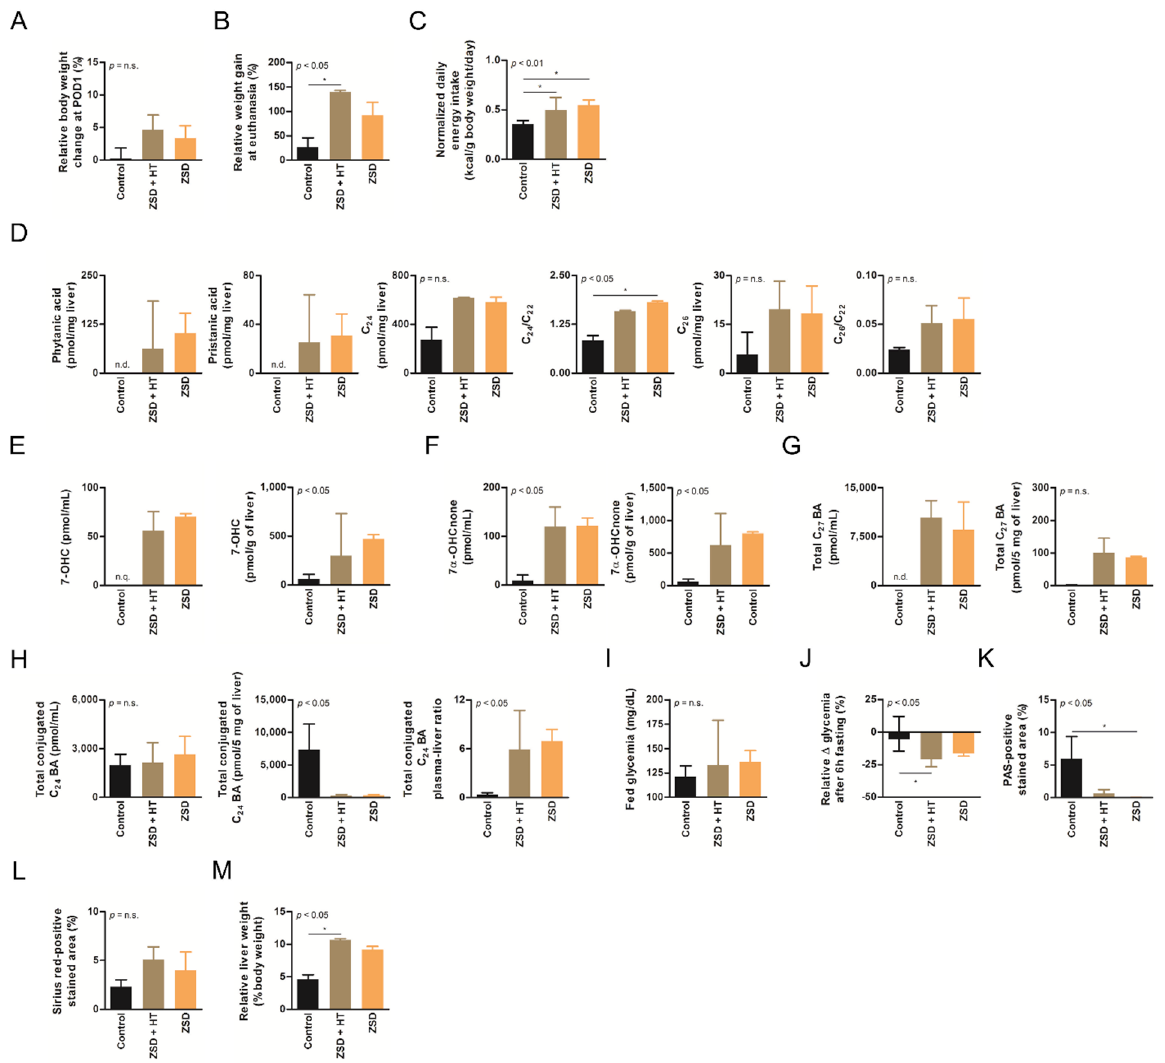
Figure 2. Low dose hepatocyte transplantation (HT) did not impact ZSD mice disease markers. ( A ) Relative body weight change at post-operative day (POD) 1, ( B ) relative weight gain at final follow-up, ( C ) normalized daily energy intake, ( D ) liver branched-chain and very long-chain fatty acids levels and ratio on C 22 , ( E ) plasma and liver oxysterols 7-hydroxycholesterol (7-OHC) and ( F ) 7 α -hydroxycholestenone (7 α -OHCnone) levels, ( G ) plasma and liver total C 27 bile acids (BA) precursors levels, ( H ) plasma, liver and plasma-liver ratio of total conjugated C 24 BA levels, ( I ) fed glycemia, ( J ) relative fasting glycemia drop (both fasting tests gave similar results and were merged on the graph, an outlier control mice was excluded from both tests), ( K ) relative liver Periodic-acid Schiff (PAS)-positive stained area (proxy for glycogen content), ( L ) relative liver Sirius red-positive stained area (proxy for collagen content) and ( M ) relative liver weight at sacrifice in control ( n = 6), Zellweger spectrum disorder (ZSD) mice infused with low dose HT ( n = 3) and ZSD mice sham operated ( n = 2). HT outcome measures highlighted disease phenotype in ZSD mice but failed to detect low dose HT impact in treated mice. Kruskal-Wallis test, n (Control – ZSD + HT – ZSD) = 6 – 3 – 2 (except for D: n = 3 – 3 – 2 and J: n = 10 – 6 – 4), median ± interquartile range, *: p -value < 0.05, n.s.: not significant.